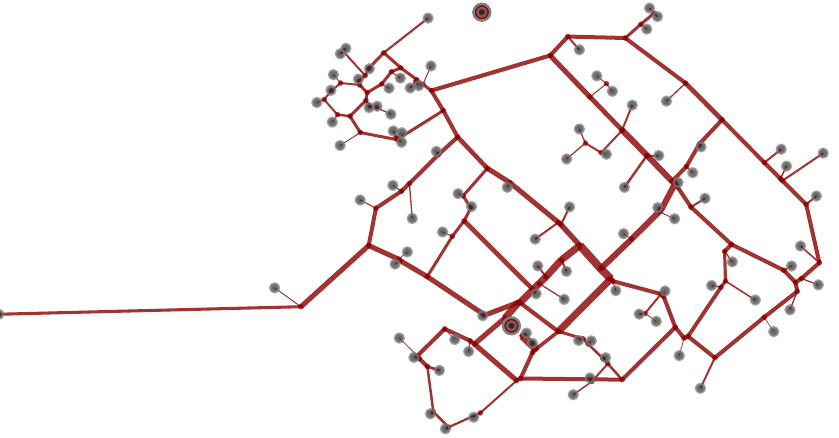
Figure 3. The meshed network structure of the district heating system at the FZJ: The various thicknesses of the edges symbolise the diameter of the installed pipes. Grey nodes represent the connected buildings and larger grey nodes with a red ring symbolise the heat